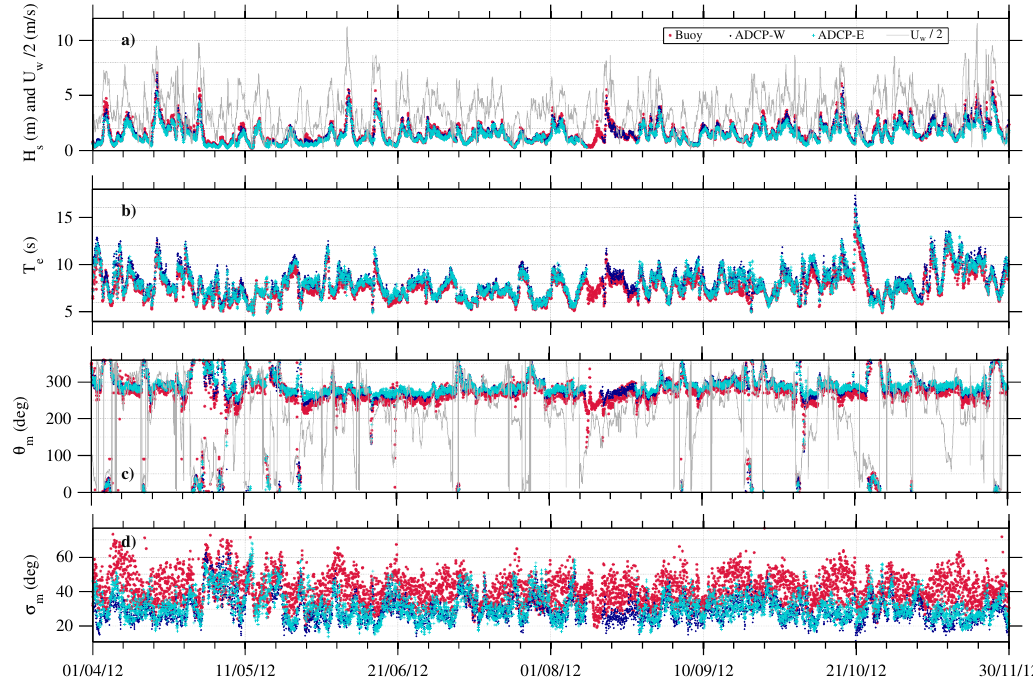
Figure 3. Same as previous figure, but showing the in situ-measured wave